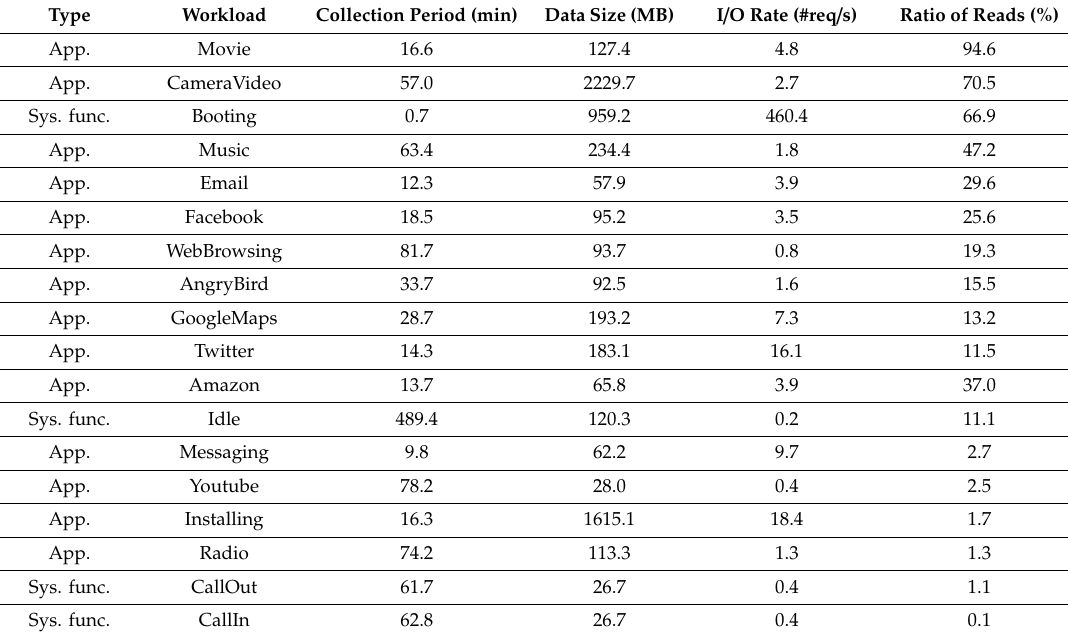
Table 5. Workloads collected from Nexus 5 smartphone (adapted from